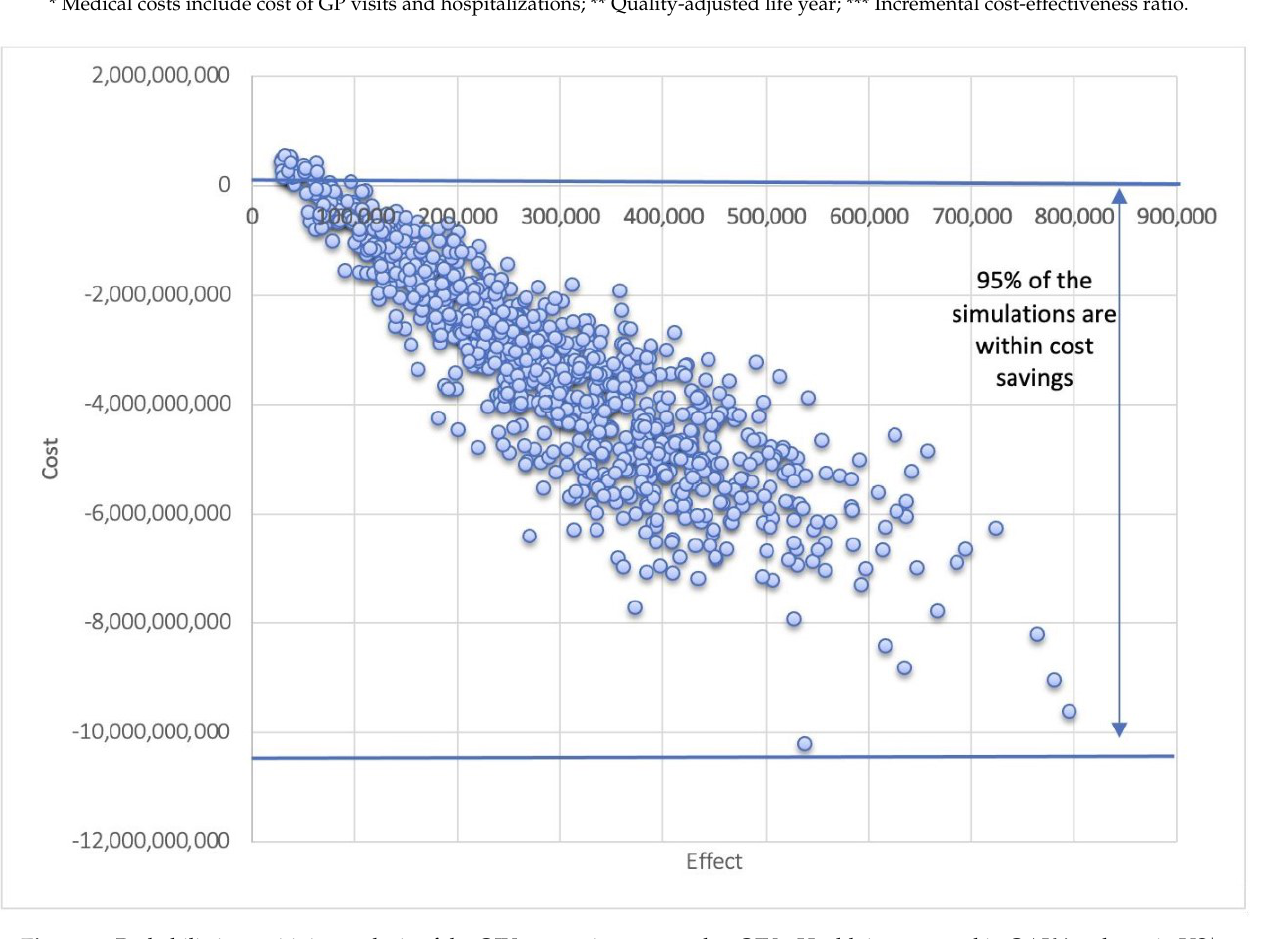
Figure 3. Probabilistic sensitivity analysis of the QIVc scenario compared to QIVe. Health is measured in QALY and cost in